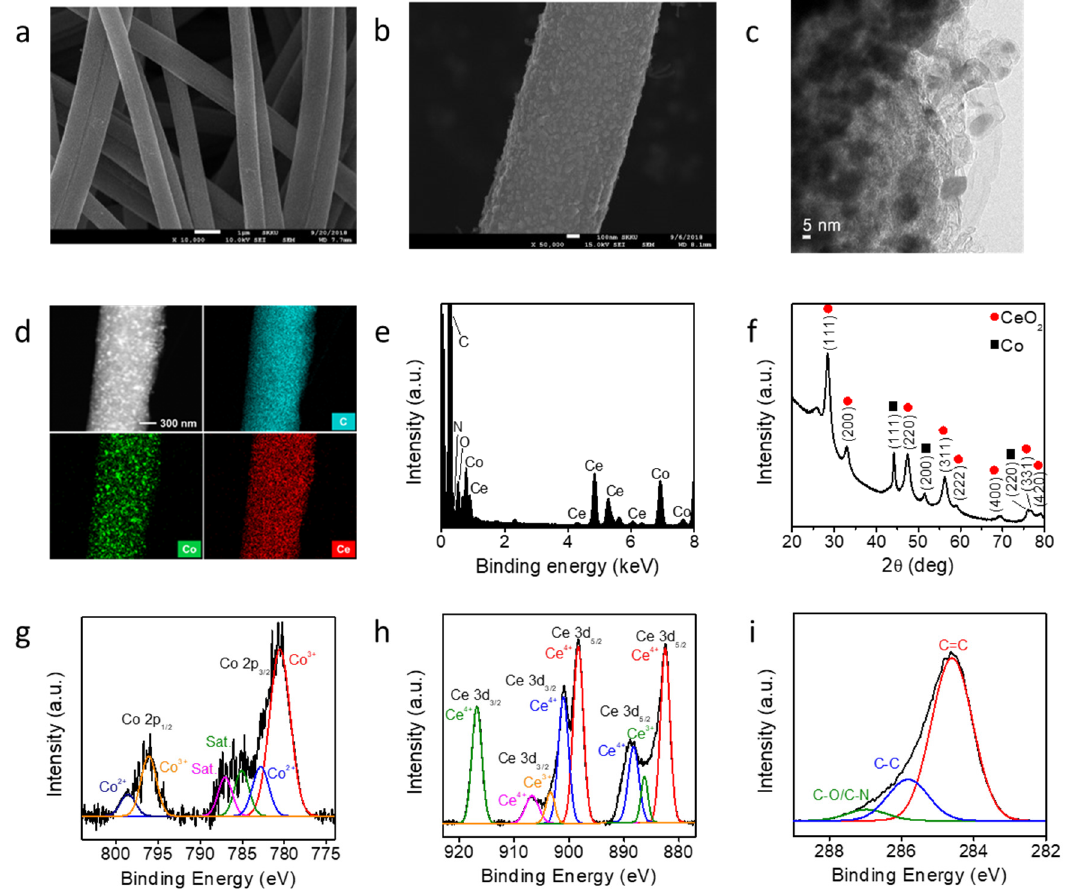
Figure 1. Characterization of Co-CeO 2 @CNF. ( a , b ) SEM and ( c ) TEM images, ( d ) scanning TEM image and EDS elemental maps, ( e ) EDS data, ( f ) XRD pattern, and ( g – i ) XPS analysis of Co-CeO 2 @CNF.